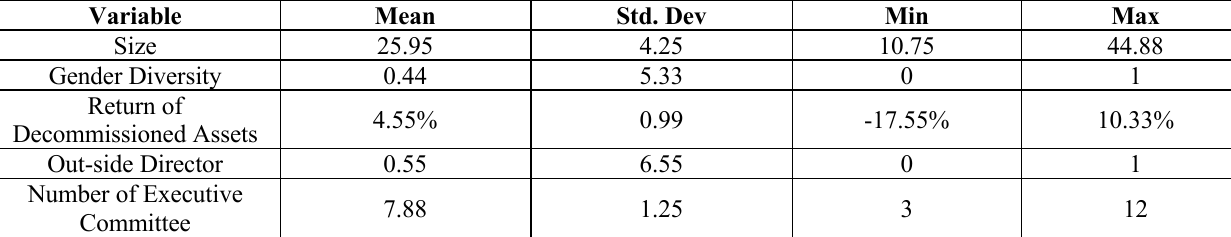
Table 7. Descriptive statistics of independent variables